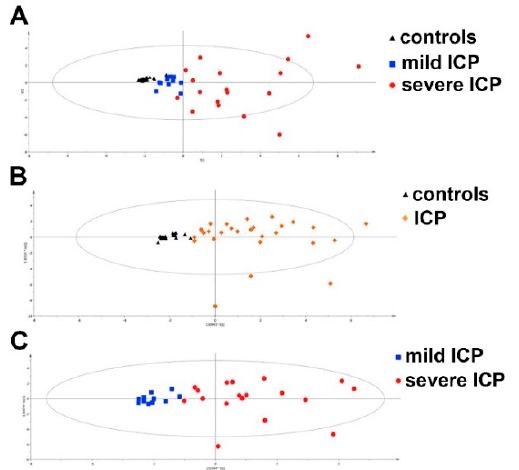
Figure 3. ( A ) PCA scores plot for controls vs. mild ICP vs. severe ICP; ( B ) OPLS-DA scores plot for controls vs. ICP; ( C ) OPLS-DA scores plot for mild ICP vs. severe ICP. Note the data clustering and separation (taken from Li et al., 2018 [112] with permission). Cholestasis may also occur in neonates. Infantile hepatitis syndrome (IHS) and biliary atresia (BLA) are the most common in the first three months of life. Using GC-MS metabolomics on urine, it